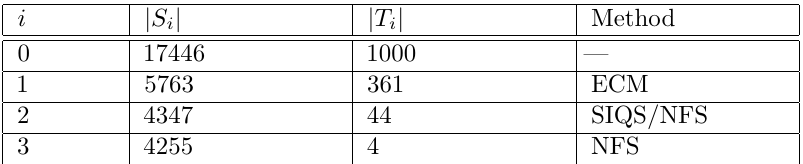
Table 3: Factoring effort over all attack trials spanning various